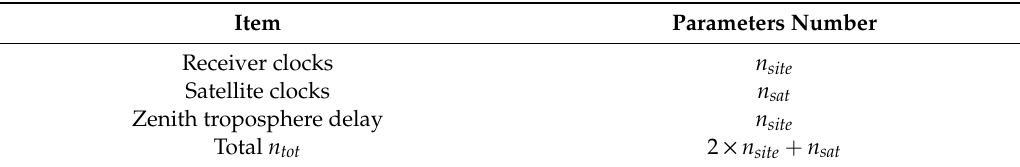
Table 2. Parameters to be estimated at each epoch in the epoch-di ff erenced (ED) model.